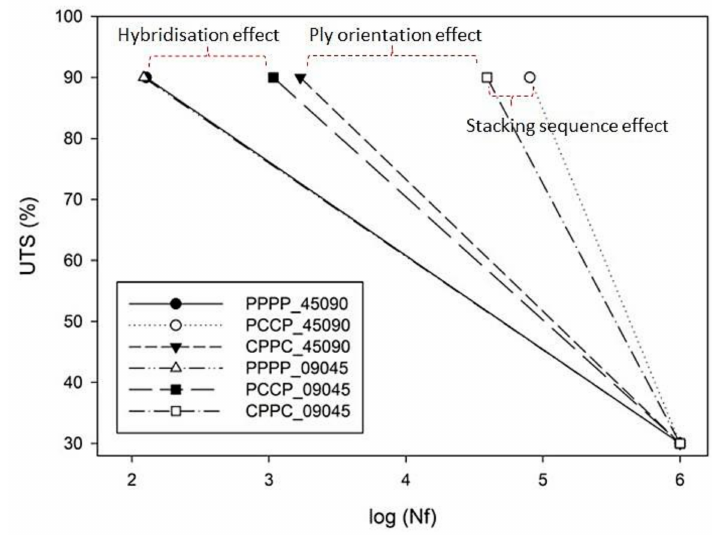
Figure 3. Plots normalised to UTS as a function of the life